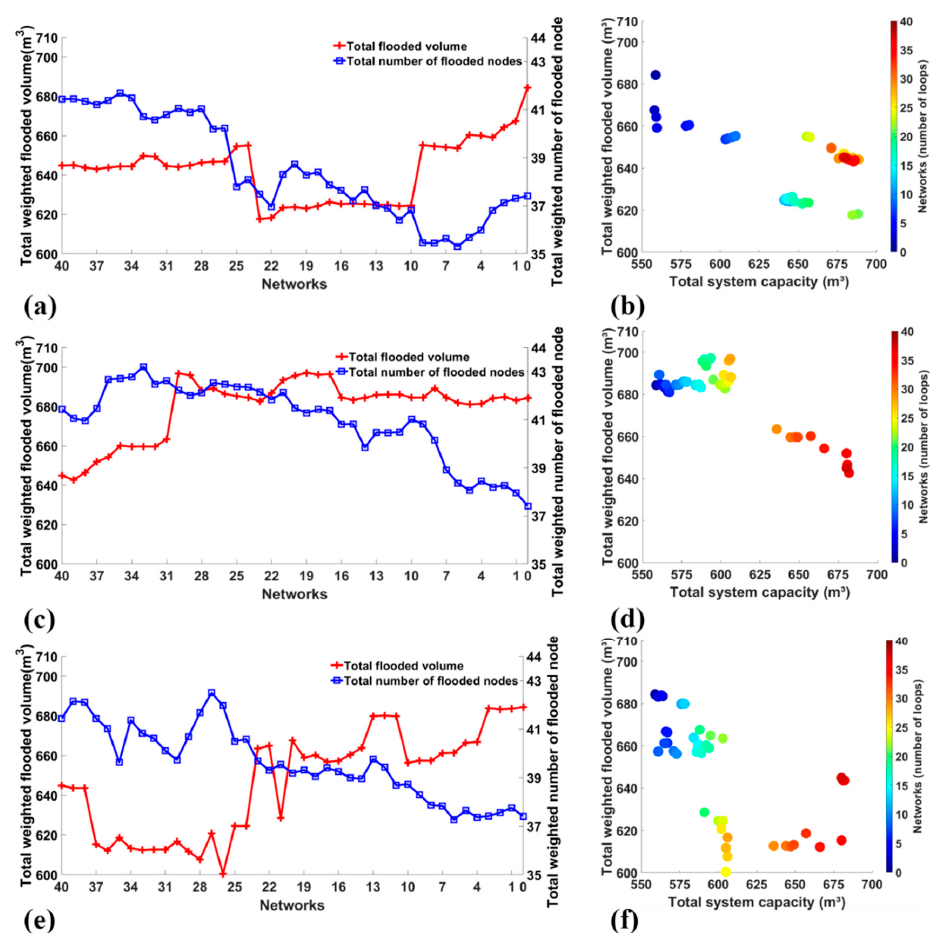
Figure 3. Hydraulic performance of all networks (left sides) and the relationship between total weighted flooded volume and total system capacity for all networks (right sides). ( a ) and ( b ) are the cases where extra pipes are removed from upstream, ( c ) and ( d ) are the cases where extra pipes are removed from downstream, ( e ) and ( f ) are the cases where the extra pipes are removed randomly.